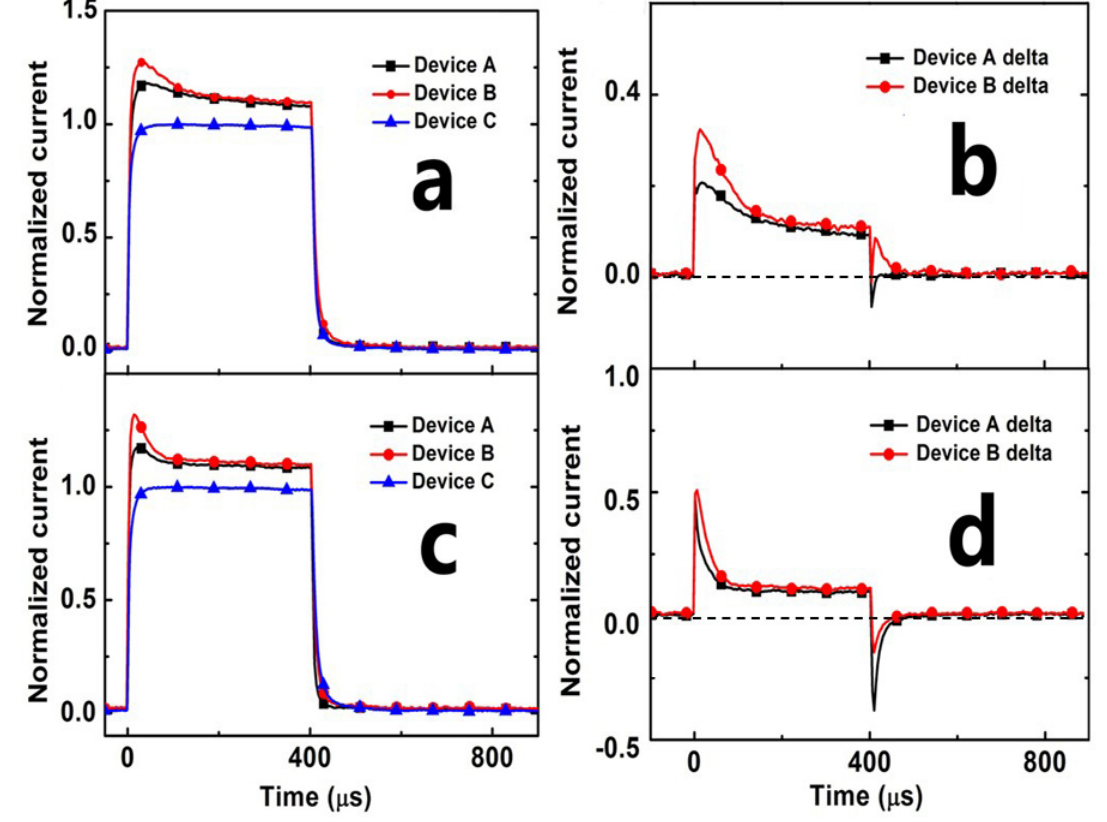
Figure 5. Normalized current response curve comparison of devices A, B and C ( a , c ); the normalized Δ I SC of devices A and B ( b , d ). Both devices were under the maximum intensity of 380 nm ( a , b ) and 520 nm ( c , d ) light